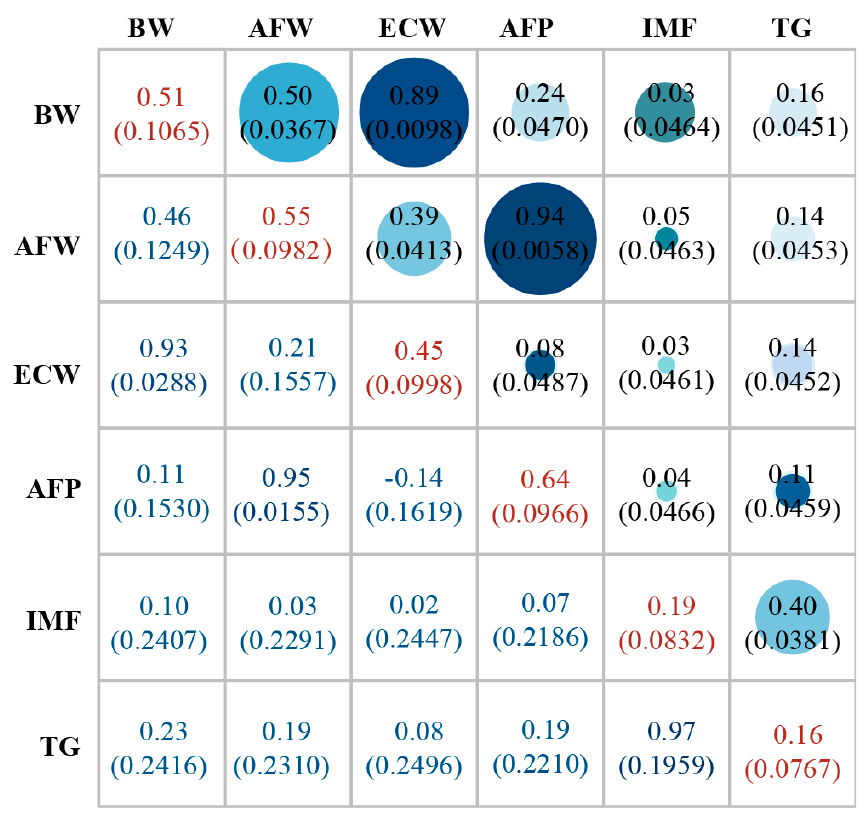
Figure 1. Genetic parameters and phenotypes. The upper triangle is phenotypic correlation coefficient (SD, standard error), the lower triangle is genetic correlation coefficient (SD, standard error), and the diagonal is heritability (SD, standard